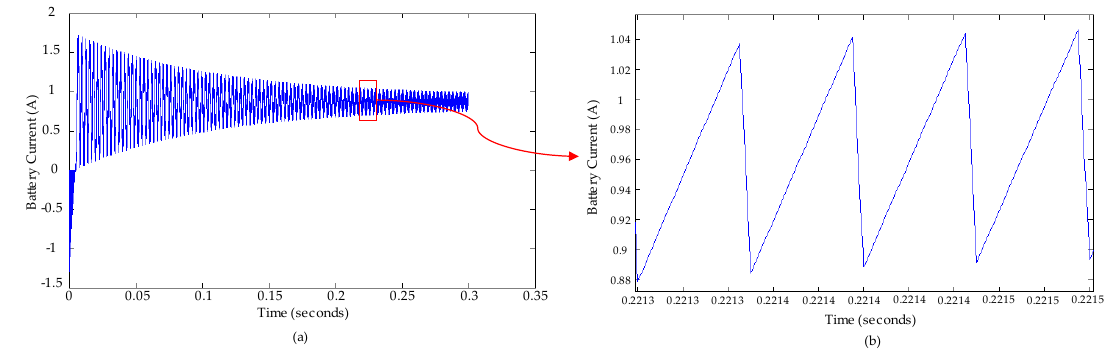
Figure 7. ( a ) Battery current for open loop; ( b ) Extended section for range (0.2213–0.2215 s).